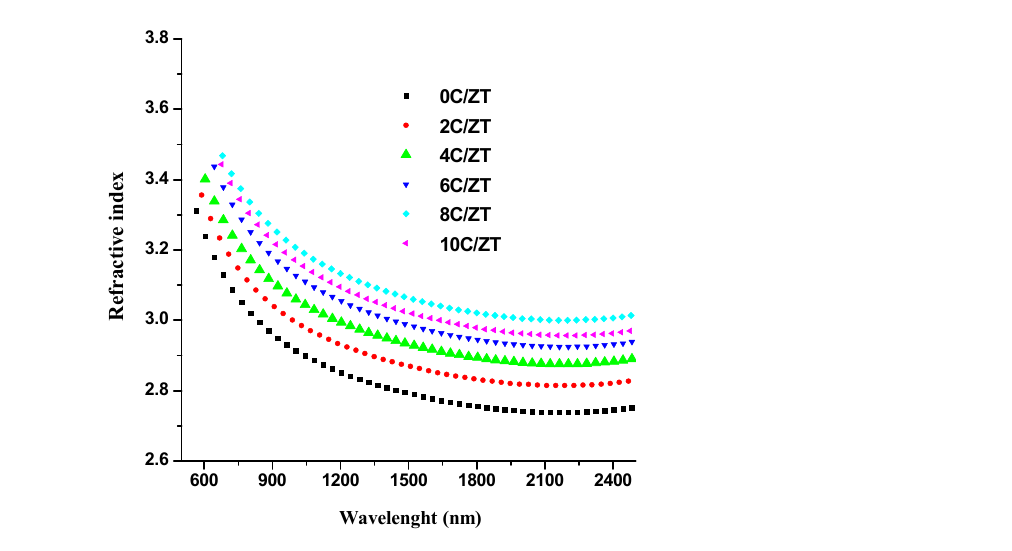
Figure 8. Dispersion of the refractive index of the ZnTe:Cu thin films obtained from Swanepoel’s method. The transmission curve also dropped at the absorption edge due to the transit of electrons from the valence band (VB) to the conduction band (CB). An additional investigation demonstrated that the basic energy gap narrows with an increase in Cu doping. As the Cu concentration of the ZnTe increases, the absorption edge redshifts. According to observations of transmission and reflection in the high absorption region, the absorption coefficient of a nanostructured Cu-doped ZnTe film with varied Cu dopants is derived from Figure 9 as an occupation of photon energy using the following relation [41]: